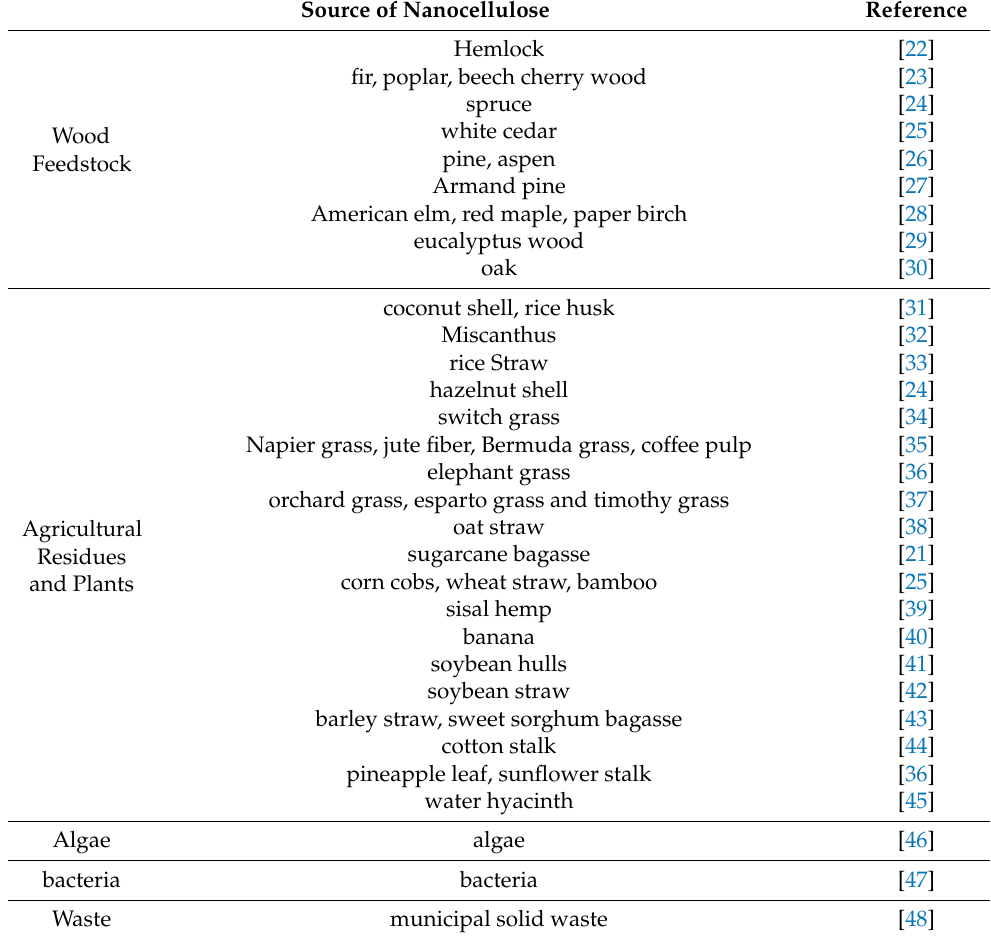
Table 2. Different Sources of